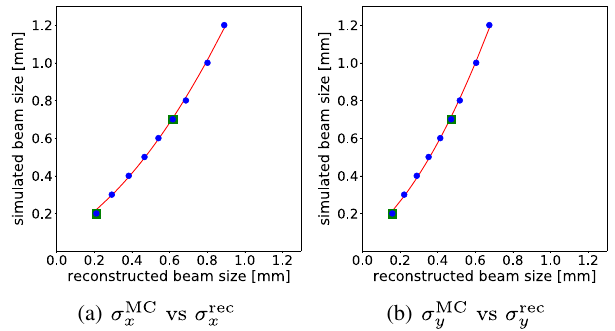
FIG. 13. Reconstructed beam size σ rec plotted against the corresponding MC generated beam size σ MC . The red line is a quadratic fit to the data. The two green squares are beam size estimations for two additional MC samples that were not used in the line